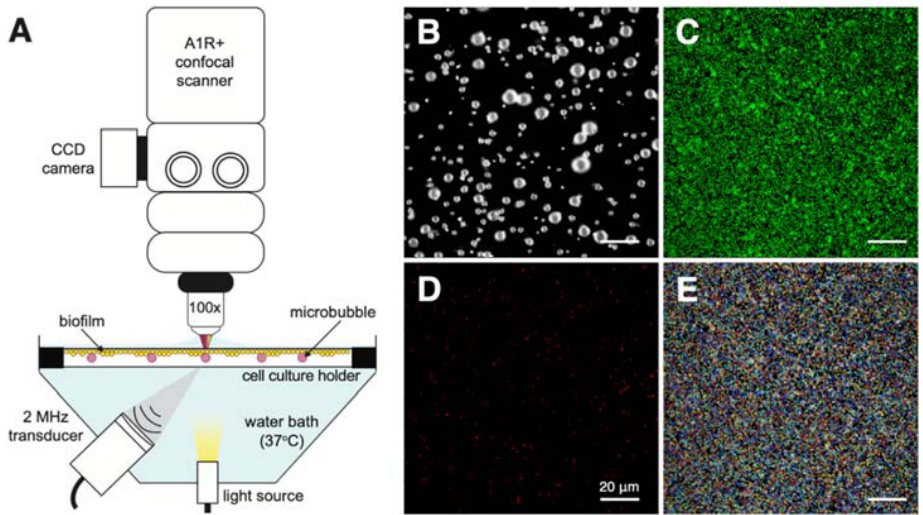
Figure 1. Experimental set-up and imaging example. ( A ) Schematic (not drawn to scale) of the experimental set-up, allowing for simultaneous optical imaging and ultrasound insonification, with the bacterial biofilm and microbubbles in the cell culture holder, i.e., OptiCell. Confocal image example of all three channels, where ( B ) microbubbles are fluorescently labelled with DiD lipid dye (pseudo-colored white), ( C ) living bacteria stained with SYTO 9 (pseudo-colored green), and ( D ) dead/membrane-compromised bacteria stained with propidium iodide (pseudo-colored red). ( E ) Image output of cells from ( C ), segmented in different colors and used for quantitative analysis. All scale bars represent 20 µ